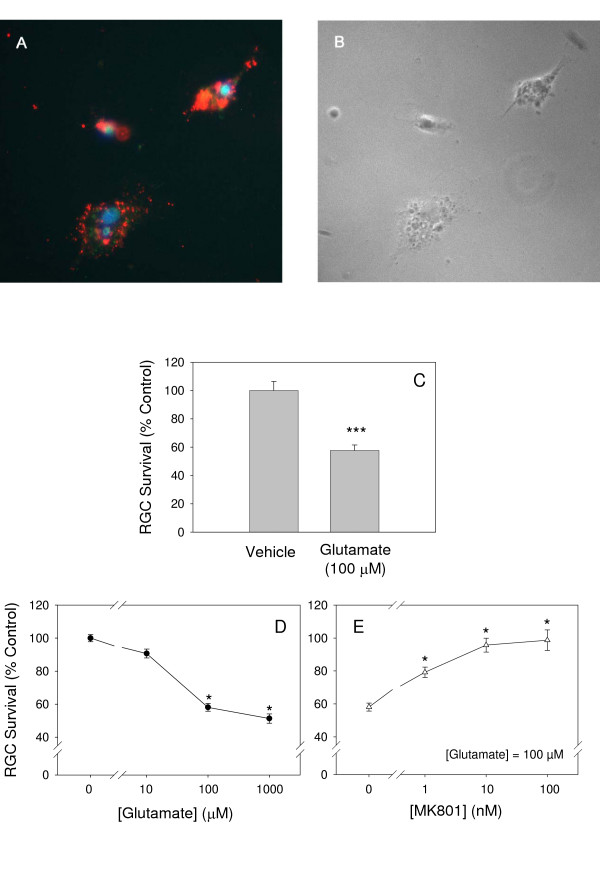
Effect of glutamate on RGC morphology and survival. Cells were treated with glutamate or vehicle for 3 days. (A and B) Morphology of RGCs with glutamate (100 μM) treatment. (A) The cells were labeled with anti-Thy-1 antibody (red) and DAPI nuclear stain (blue). (B) The corresponding phase-contrast image. (C) Effect of glutamate (100 μM) on RGC survival (n = 76). *** represents P < 0.001 vs. the control group by Student's t-test. (D) Concentration-dependent toxicity of glutamate on cultured RGCs (n = 6). * represents P < 0.05 vs. the control group by One-way ANOVA then Dunnett's test. (E) Effect of MK801 on glutamate-induced RGC toxicity. Cells were treated with the indicated concentrations of MK801 in the presence of 100 μM of glutamate (n = 6). * represents P < 0.05 vs. the glutamate alone group by One-way ANOVA then Dunnett's test. Cell survival in (C), (D), and (E) was assessed by manually counting the Thy-1-positive cells. Data are presented as mean ± SEM.